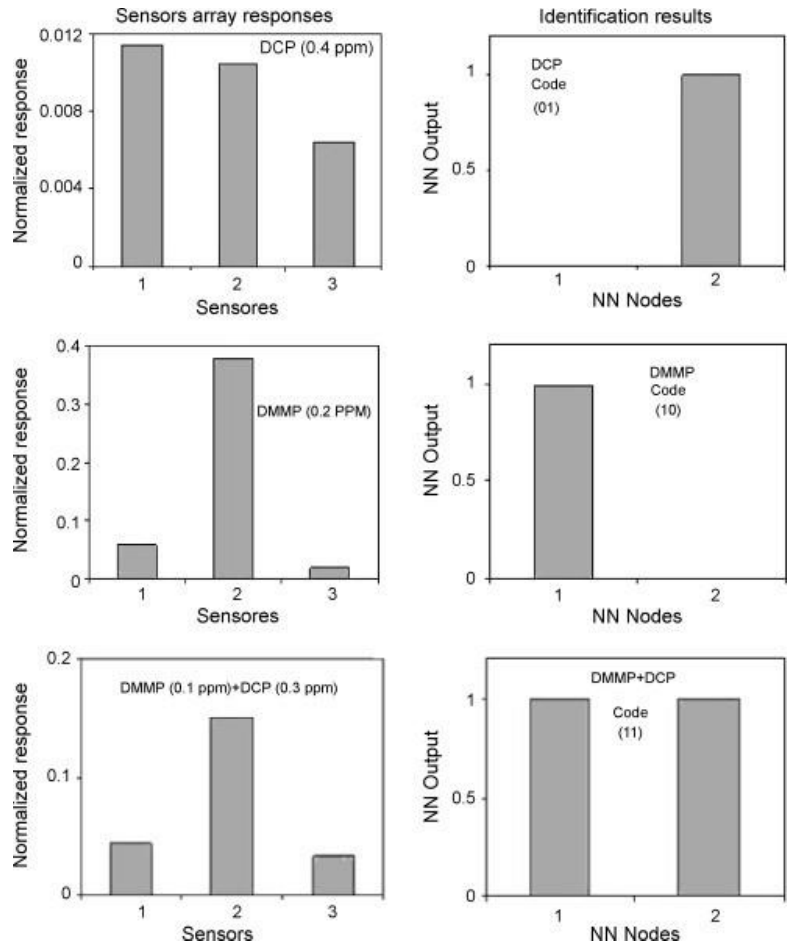
Figure 6. Examples of normalized responses of sensor array (sensor 1 — SXFA, sensor 2 — PECH, sensor 3 — OV25) for given simulant (DCP, DMMP, mixture of DCP and DMMP) and ANN classification results [63]. Reprinted with permission from [63]. Copyright 2008 Elsevier.